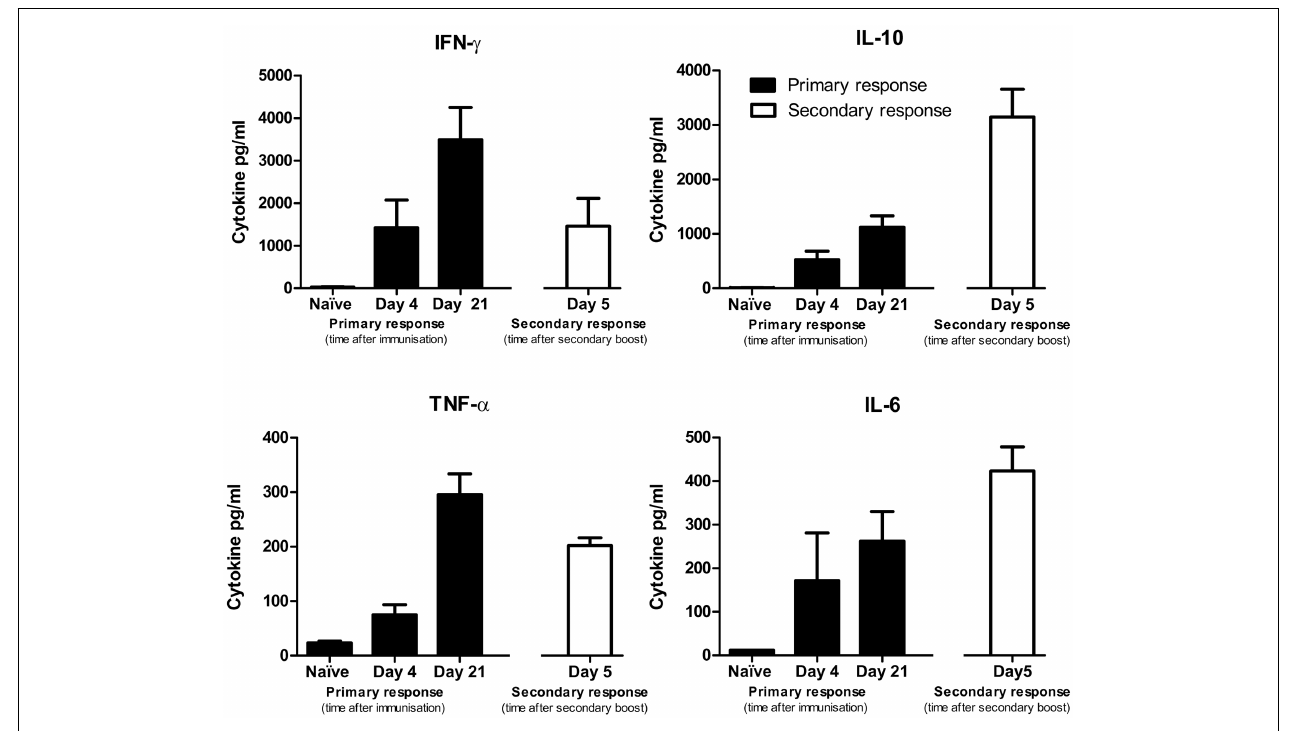
to mice immunized with 2 × 10 6 DFTD cells, rested 57days, given a second immunization with 2 × 10 6 DFTD cells and splenocytes collected 5days later. Data expressed as mean of five mice ± SEM except naïve responses ( n = 3).